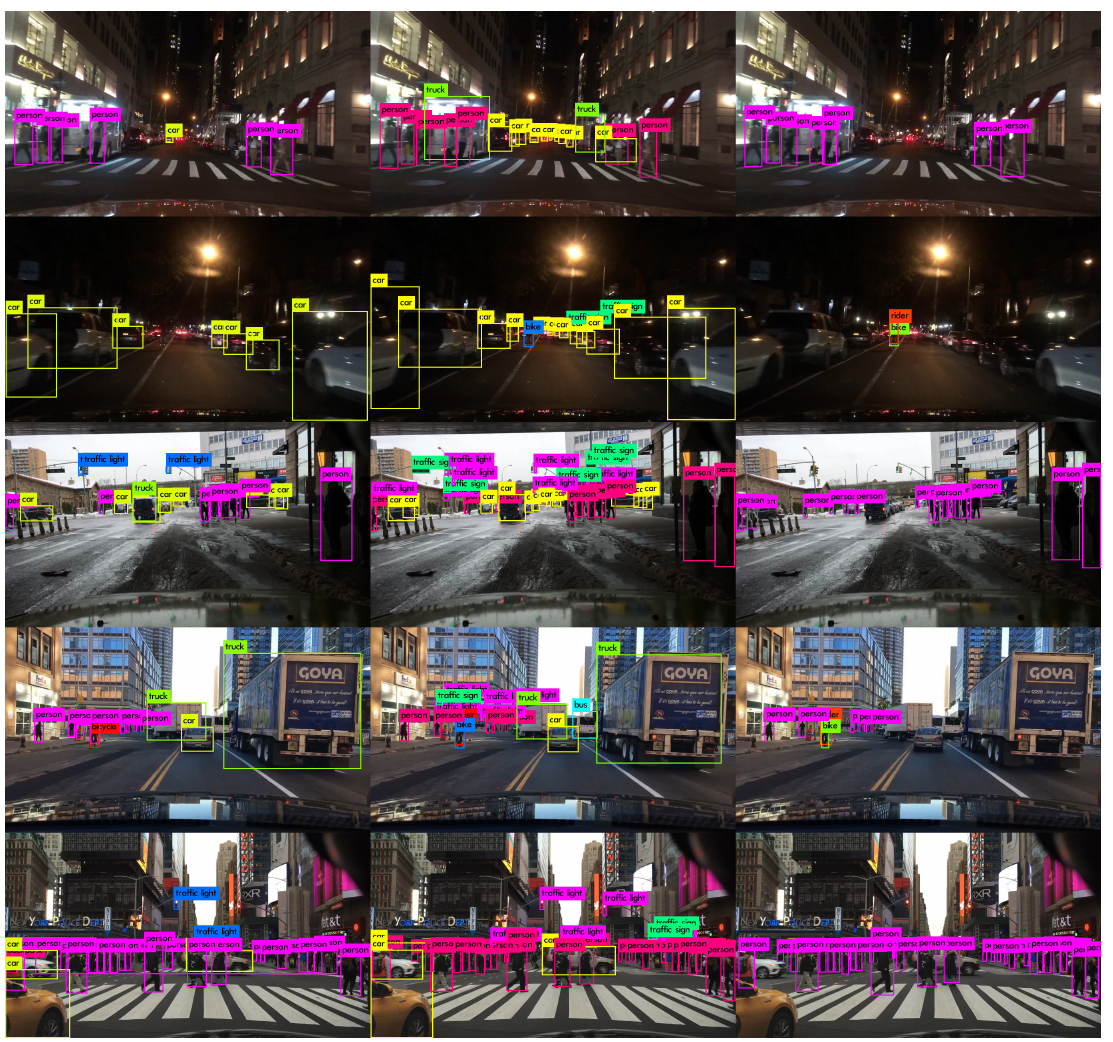
Figure 2. Some processed images from BDD100K test dataset with YOLOv3-416: original MS-COCO model from the author ( left column), our BDD100K 10-class training ( central column) and our BDD100K VRU-class training ( right